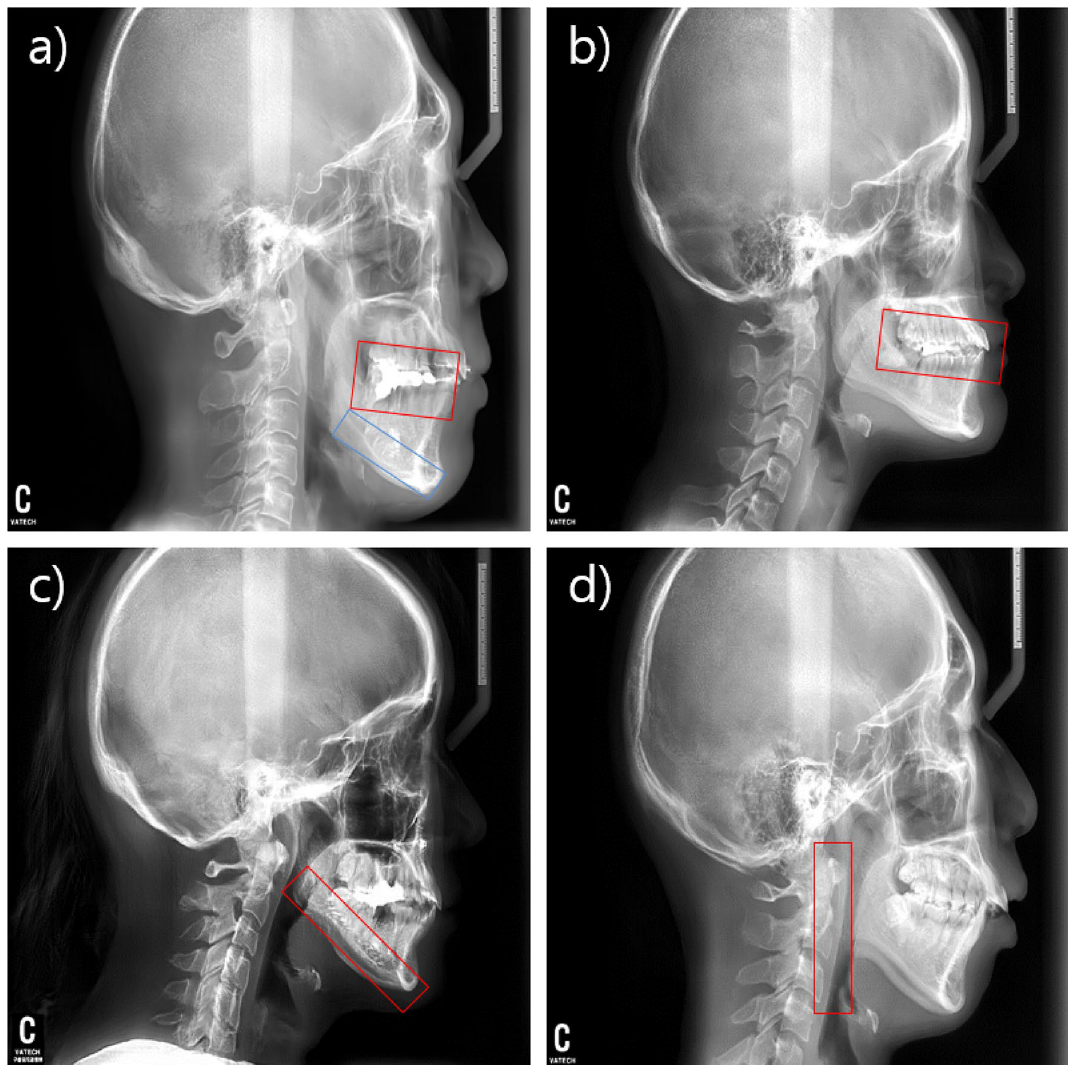
Figure 5. Regions of interest for the most prominent difference features. ( a ) Overlapped teeth region (red color) and radiopaque line (blue color). ( b ) Occlusal-plane point. ( c ) Cortical line of the mandibular. ( d ) Ramal